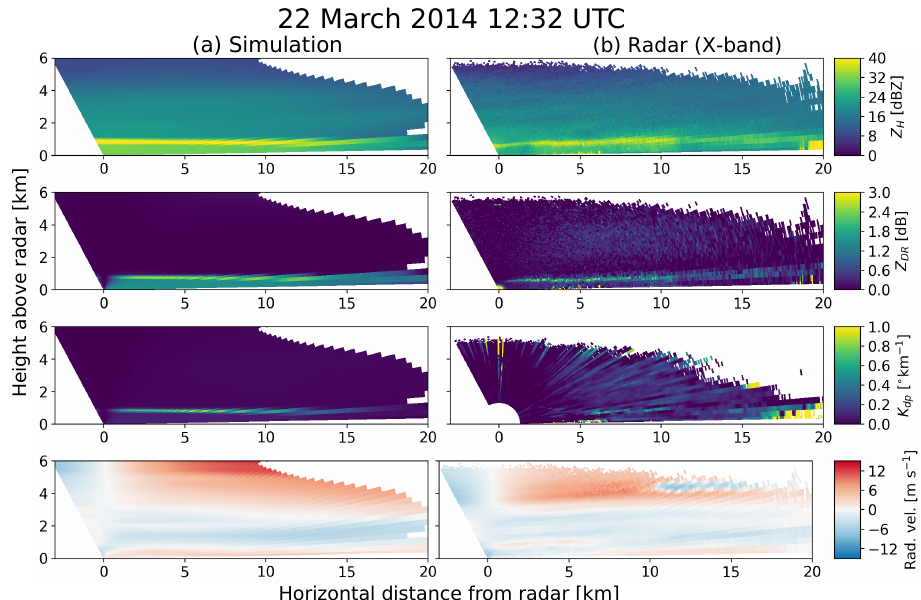
Figure 12. Example of RHI showing the observed and simulated melting layer during the PARADISO campaign in Spring 2014 (Table 3). Panel (a) corresponds to the simulated radar observables, panel (b) to the observed values at X-band. Note that there is an area with velocity folding (blue area in the middle of a larger red area) around 5km altitude and 10–15km horizontal distance on the radar RHI